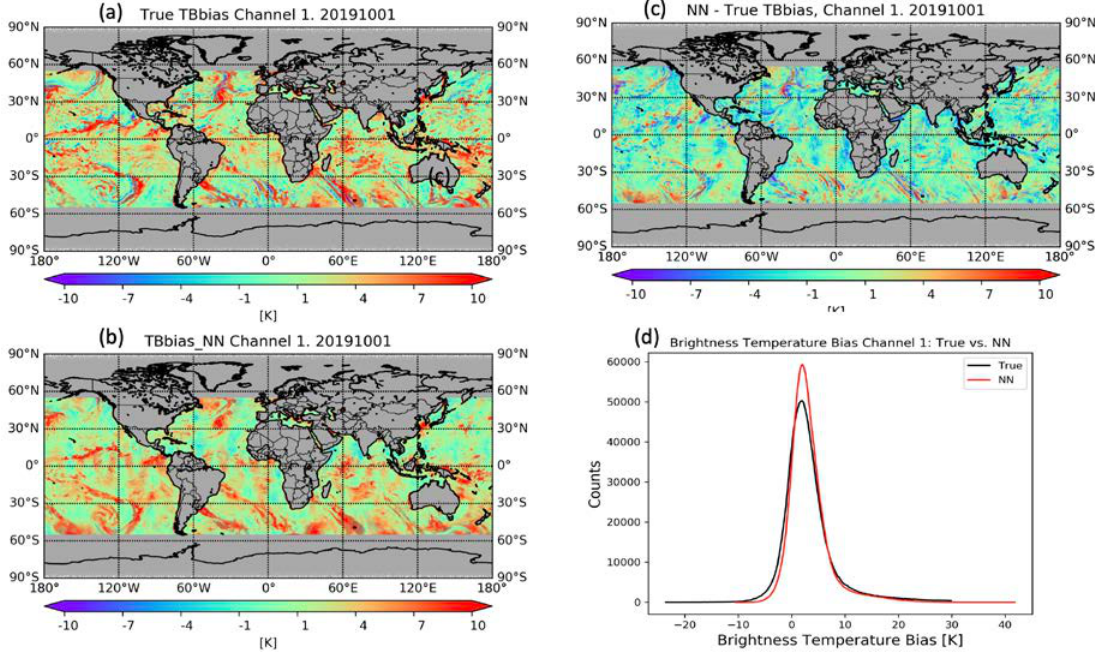
Figure 4. Brightness temperature bias [K] maps of SNPP / ATMS 23.8 GHz on 1 October 2019, over ocean with latitude between 55 S and 55 N, for ( a ) true value, ( b ) NN prediction, the difference between NN and the true value ( c ), and histograms of the true value and the NN prediction ( d ).